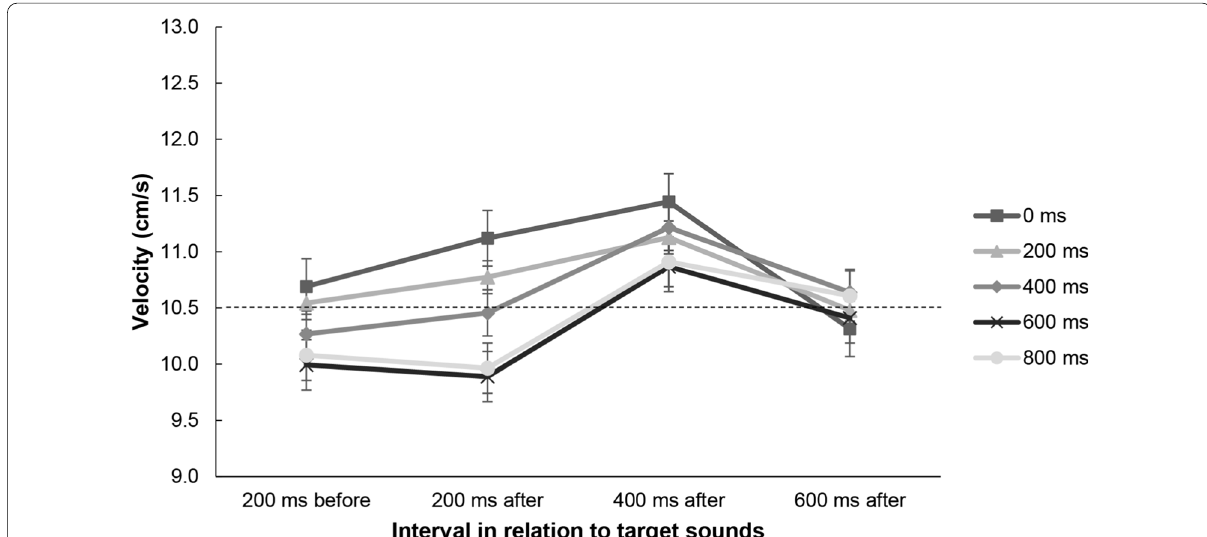
Fig. 4 Results of velocity analyses in Experiment 1. The dashed horizontal line represents the constant target velocity (10.5 cm/s). Baseline tracking velocity (i.e., 200 ms before the sound onset) was compared against 200 ms, 400 ms, and 600 ms after the sound onset. Error bars show the standard error. Different symbols represent the different predictability conditions